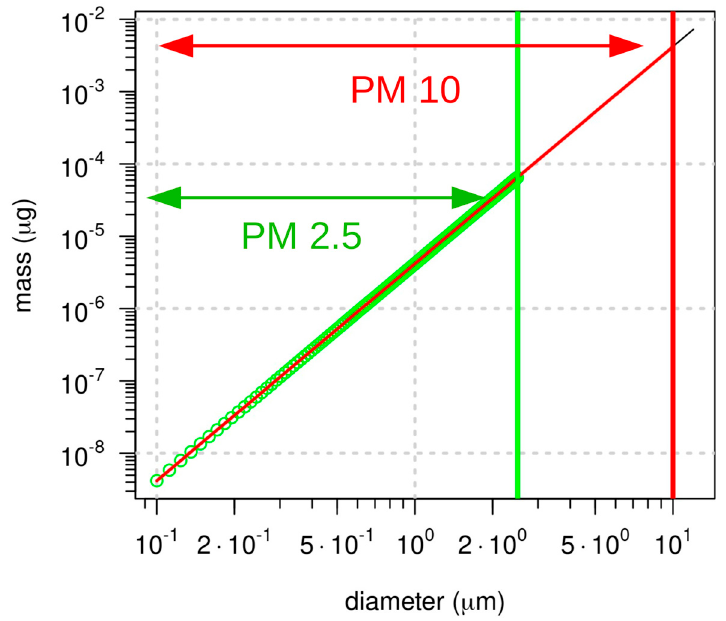
Figure 1. Mass particle vs. diameter for the two classes of particulate (PM2.5 ( green ) and PM10 ( red )) in a logarithmic scale.